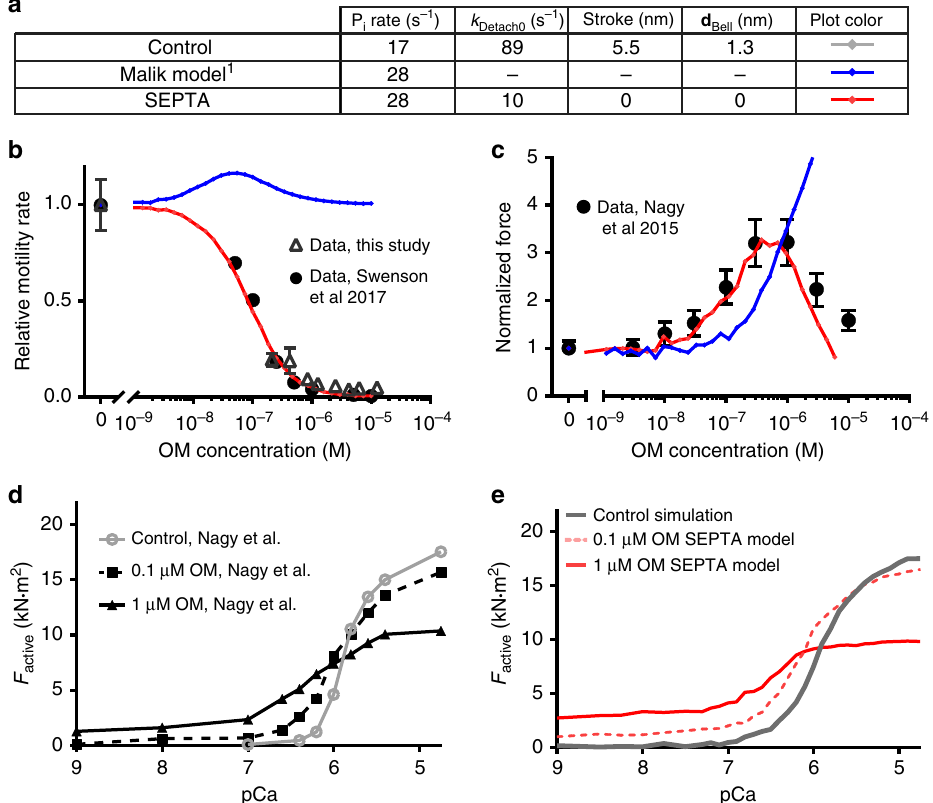
Fig. 5 Simulations of OM ’ s effect on in vitro actin gliding velocity and isometric force of muscle preparations. a Summary of parameters used in models in b – e . b Comparison of gliding fi lament velocity for the protein used in this study (open triangles) and from Swenson et al. 9 (closed circles) to simulated data from the various model parameter sets (colored lines as in a ). The Stroke Eliminated, Prolonged Time of Attachment (SEPTA) Model (red), with parameters from the single-molecule measurements, fully accounts for the observed marked decrease in vitro velocity as a function of OM concentration. Motility error bars are standard deviations of velocities from individual fi laments ( n of fi laments = 92 – 6709). c Comparison of simulated, normalized, isometric forces at an intermediate calcium concentration (15% activation, lines colored as in a ) and results from Nagy et al. 11 who reported a bell-shaped force response of permeabilized myocardial trabeculae as a function of OM (black circles). The SEPTA model (red) shows a similar biphasic shape. d Active force data reproduced from Nagy et al. as a function of pCa ( − log [Ca 2 + ]) at 0, 100 nM and 1 μ M OM. e Simulated isometric force at 0 OM (gray line), and using the SEPTA model at 100 nM (red dashed line) and 1 μ M OM (red, solid line) for comparison with the experimental data in d . The SEPTA model recapitulates the leftward shift in the pCa-tension curve (calcium sensitization) and decreased force production at fully activating [Ca 2 +